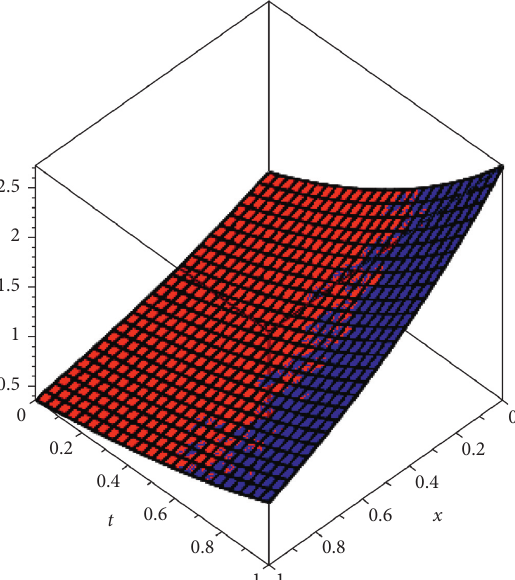
Figure 5: Comparison of the exact solution (blue) and the approximate solutions (red) of Example 5 for α �